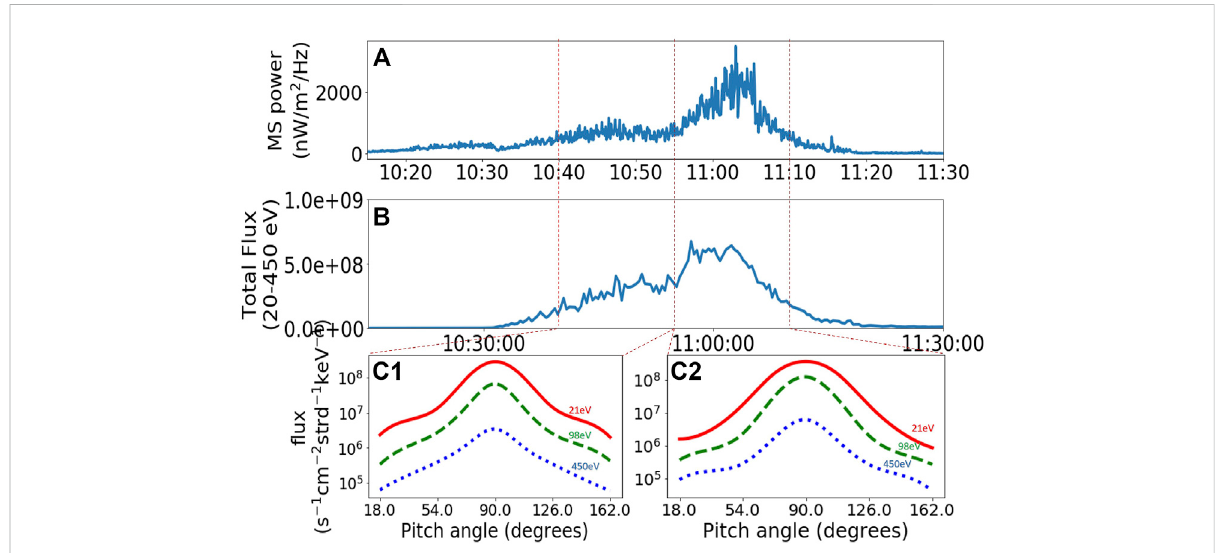
FIGURE 3 Comparison of pitch angle distribution of thermal/suprathermal protons in two adjacent time intervals. Panel (A) shows the Poynting fl ux densityofMSwaves.Panel (B) showsthe fl uxdensityofprotonsintheenergyrangeof21 – 450 eV.Panel (C1) , (C2) showsthepitchangledistributions of protons at energies 21 eV (red), 98 eV (green), and 450 eV